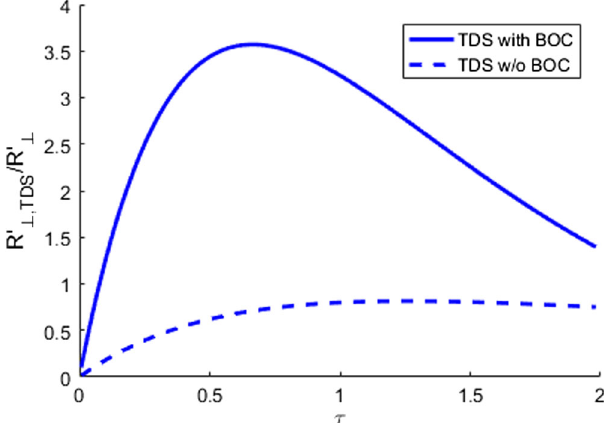
FIG. 10. Effective transverse shunt impedance per meter length for the TDS with (solid) and without (dashed) BOC versus TDS attenuation τ .